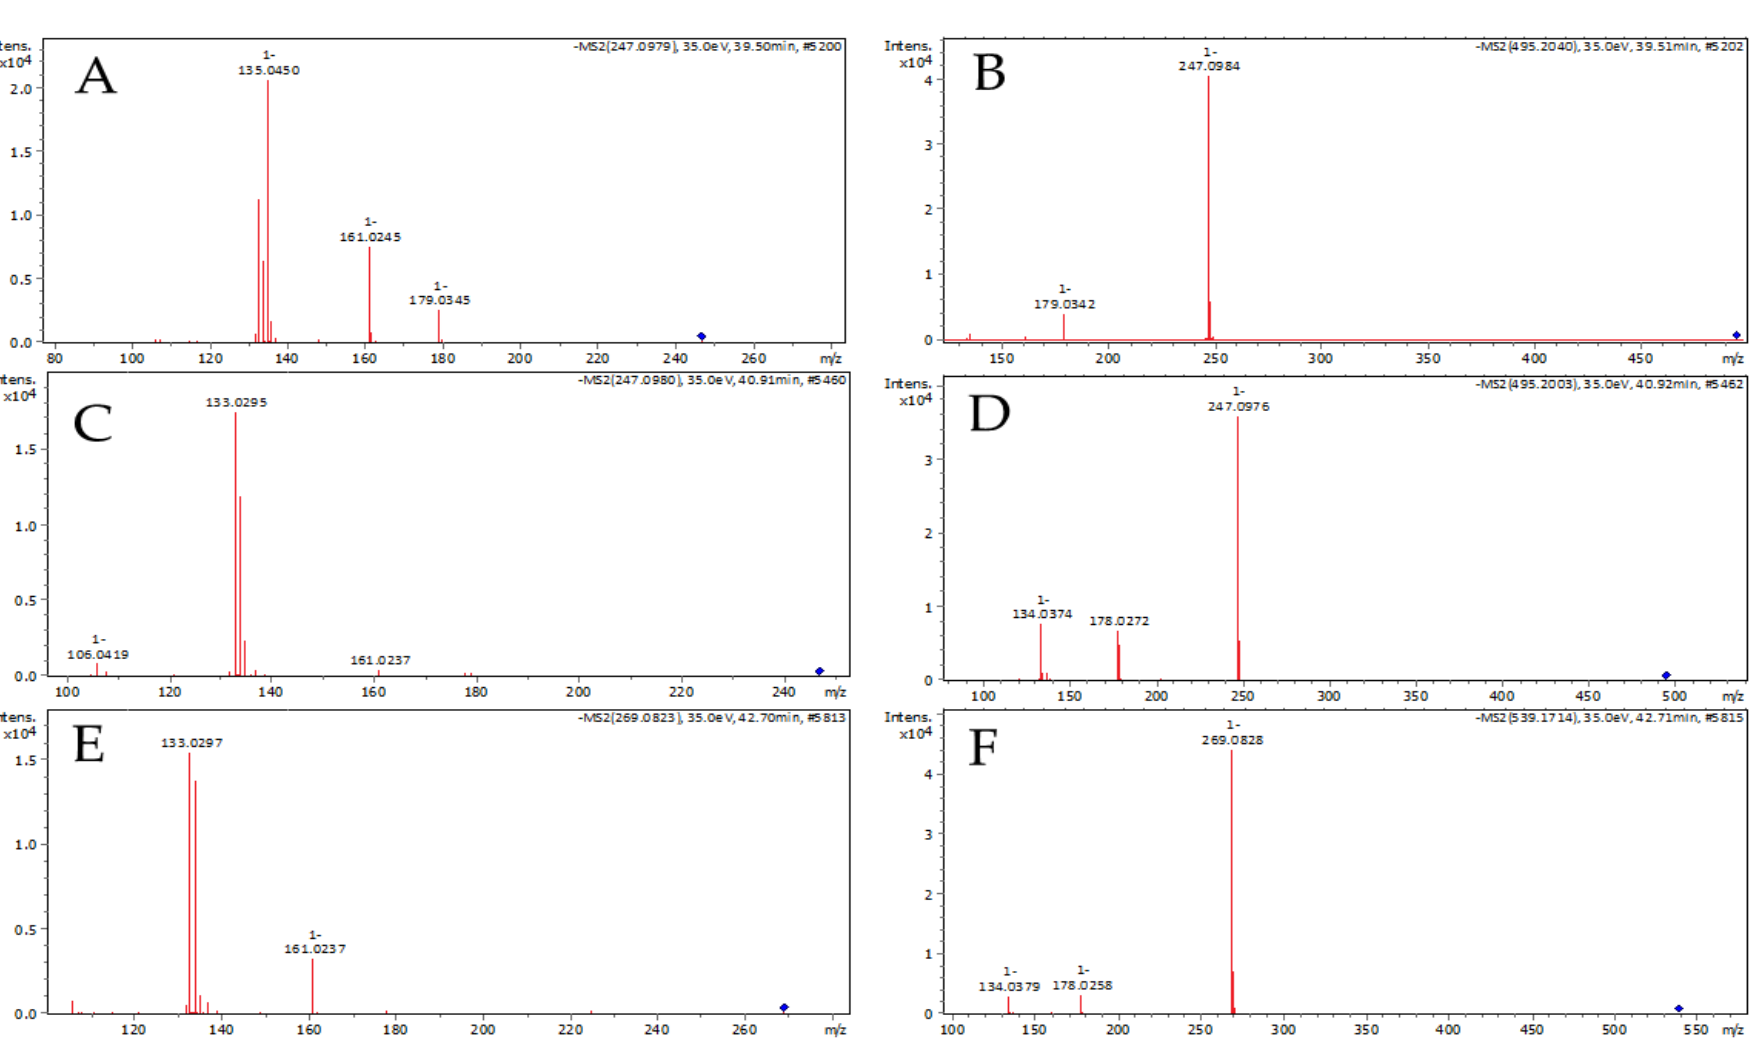
Figure 3. Experimental MS/MS spectra of caffeic acid esters and corresponding dimeric forms. Caffeic acid 2-methyl-2-butenyl ester ( A ) and its dimer ( B ); caffeic acid 3-methyl-2-butenyl ester ( C ) and its dimer ( D ); caffeic acid benzyl ester ( E ) and its dimer ( F ).